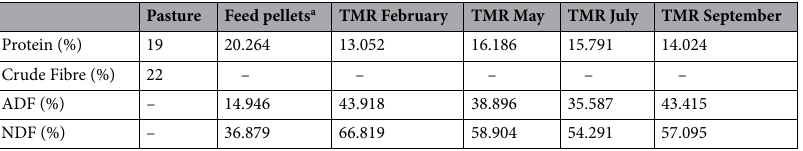
Table 1. Nutritional composition (dry matter) of the supplemented total mixed ration (TMR), feed pellets and pasture used along the study. a Supplemented only to stags during February, May, and